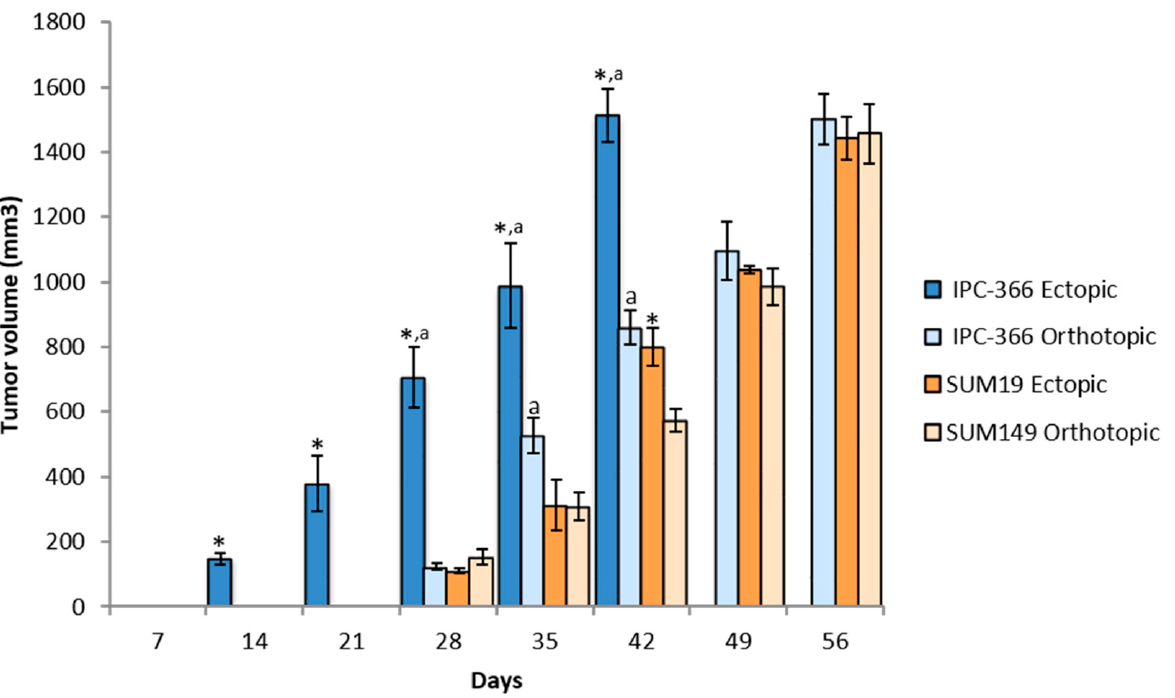
Figure 1. Tumor growth progression in ectopic and orthotopic models. The two injection models of both cell lines showed a fast pattern of tumor growth progression. Bar represents means ± SD * p < 0.05; significant differences between ectopic and orthotopic models on each cell line. a; significant differences ( p < 0.05) between cell lines in each group (ectopic and orthotopic).